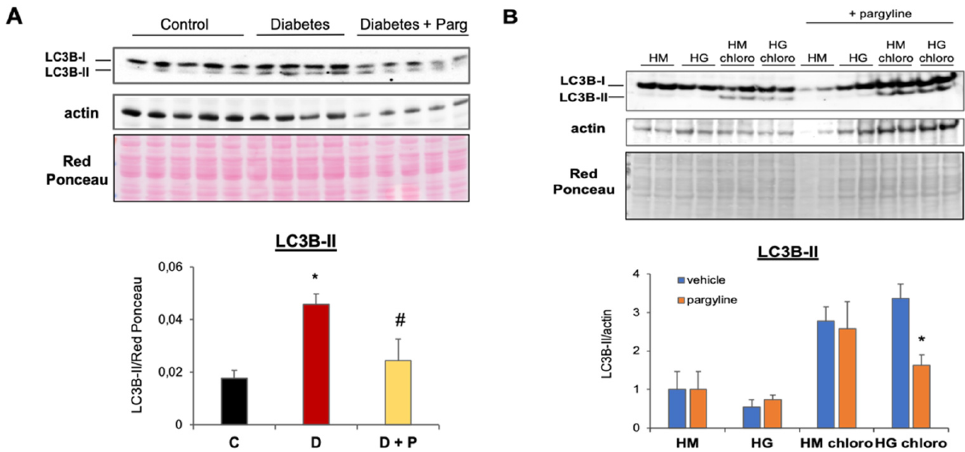
Figure 2. Effects of MAO inhibition on autophagy flux in T1D hearts and NRVMs cultured with high glucose. ( A ) Representative Western blot (upper panel) and densitometry analyses (lower panel) of the autophagy marker LC3B-II in control (C), diabetic (D) and diabetic mice treated with the MAO inhibitor pargyline (D + P). Values were normalized to actin or Red Ponceau staining. * p ≤ 0.05 vs. C; # p ≤ 0.05 vs. D, by Dunn’s non-parametric test. ( B ) Representative Western blots (upper panel) and densitometry analyses (lower panel) of LC3B-II in NRVMs cultured with the osmotic control mannitol (HM) or high glucose (HG) at baseline or after treatment with the inhibitor of lysosomal degradation chloroquine (chloro). Parallel experiments were performed in the presence of MAO inhibitor pargyline. Values were normalized to actin. LC3B-II abundance in HM groups was arbitrarily considered as a unit. * p ≤ 0.05 vs. HG chloro, with two-tailed equal variance t -test.